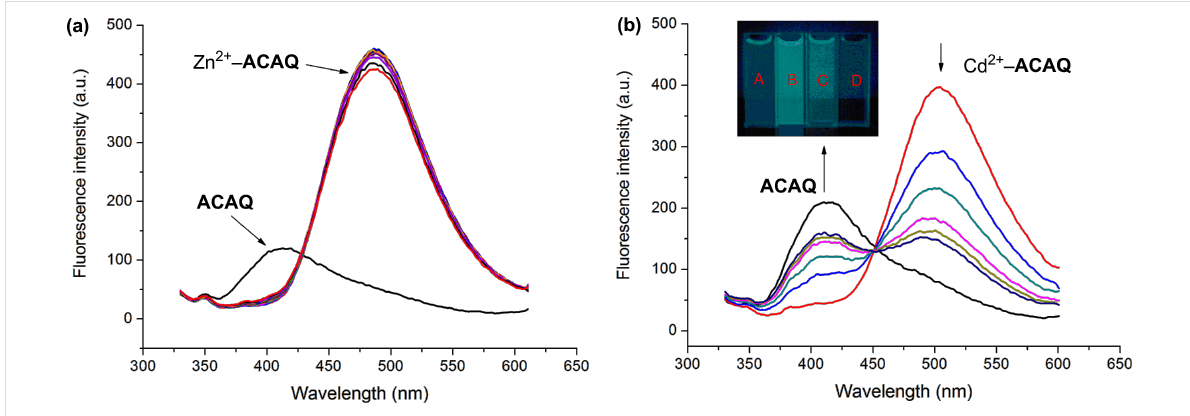
Figure 3: Emission spectra of (a) Zn 2+ – ACAQ or (b) Cd 2+ – ACAQ complex (5 μ M) at increasing concentrations of Cys (0, 1.0, 2.0, 3.0, 4.0, 5.0 equiv) in buffered solution (10 mM, HEPES, 80% ACN, pH 7.4) at 298 K. Excitation wavelength was 315 nm. Inset in (b): Visible emission (irradiated by 365 nm light) observed. A: Only ACAQ ; B: Cd 2+ – ACAQ ; C: Cd 2+ – ACAQ/ 0.5 equiv Cys; D: Cd 2+ – ACAQ/ 2.0 equiv Cys.